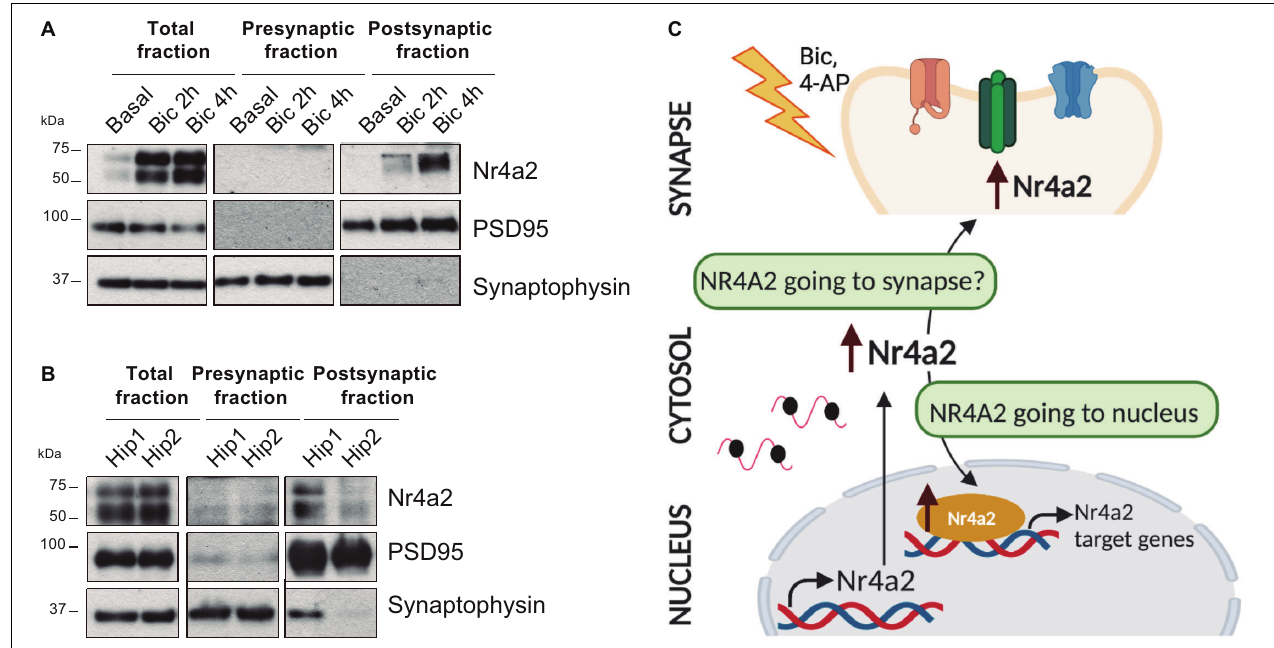
FIGURE 2 | Nr4a2 transcription factor is present at the postsynaptic density both in mature hippocampal-cultured neurons and the adult mouse hippocampus. (A) Synaptoneurosomes from mature hippocampal-cultured neurons after bicuculline (bic; 50 µ M) treatment. (B) Synaptoneurosomes of adult mouse hippocampus (hip). All figures correspond to representative images from Western blotting analysis. n ≥ 3. (C) Schematic model of Nr4a2 mobilization to nucleus and postsynaptic density fractions after neuronal